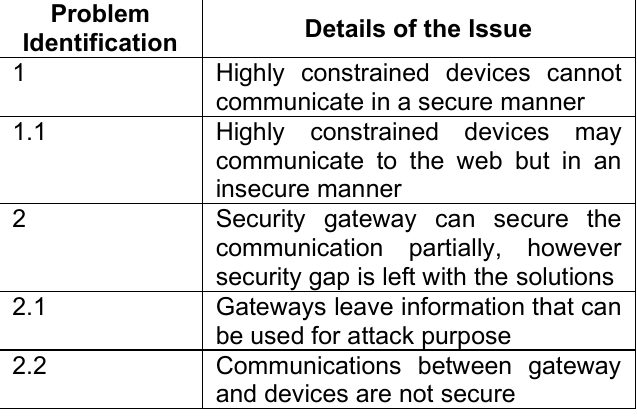
Table 2. Description of